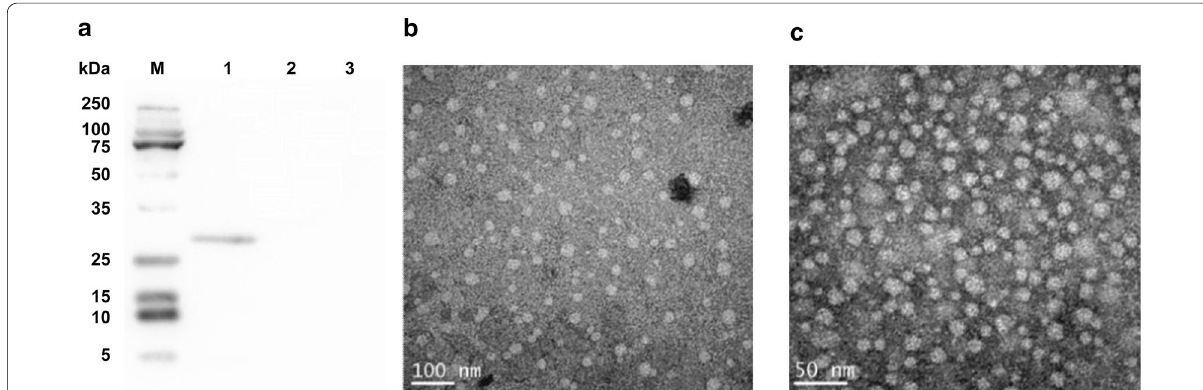
Fig. 1 a Immunoblot of recombinant cap proteins showing that PCV2 cap protein was correctly expressed Sf9 cells infected with recombinant Ac-orf2 are shown in lane 1, wildtype AcMNPV-infected Sf9 cells are in lane 2, and uninfected Sf9 cells are in lane 3. Lane M contained standard